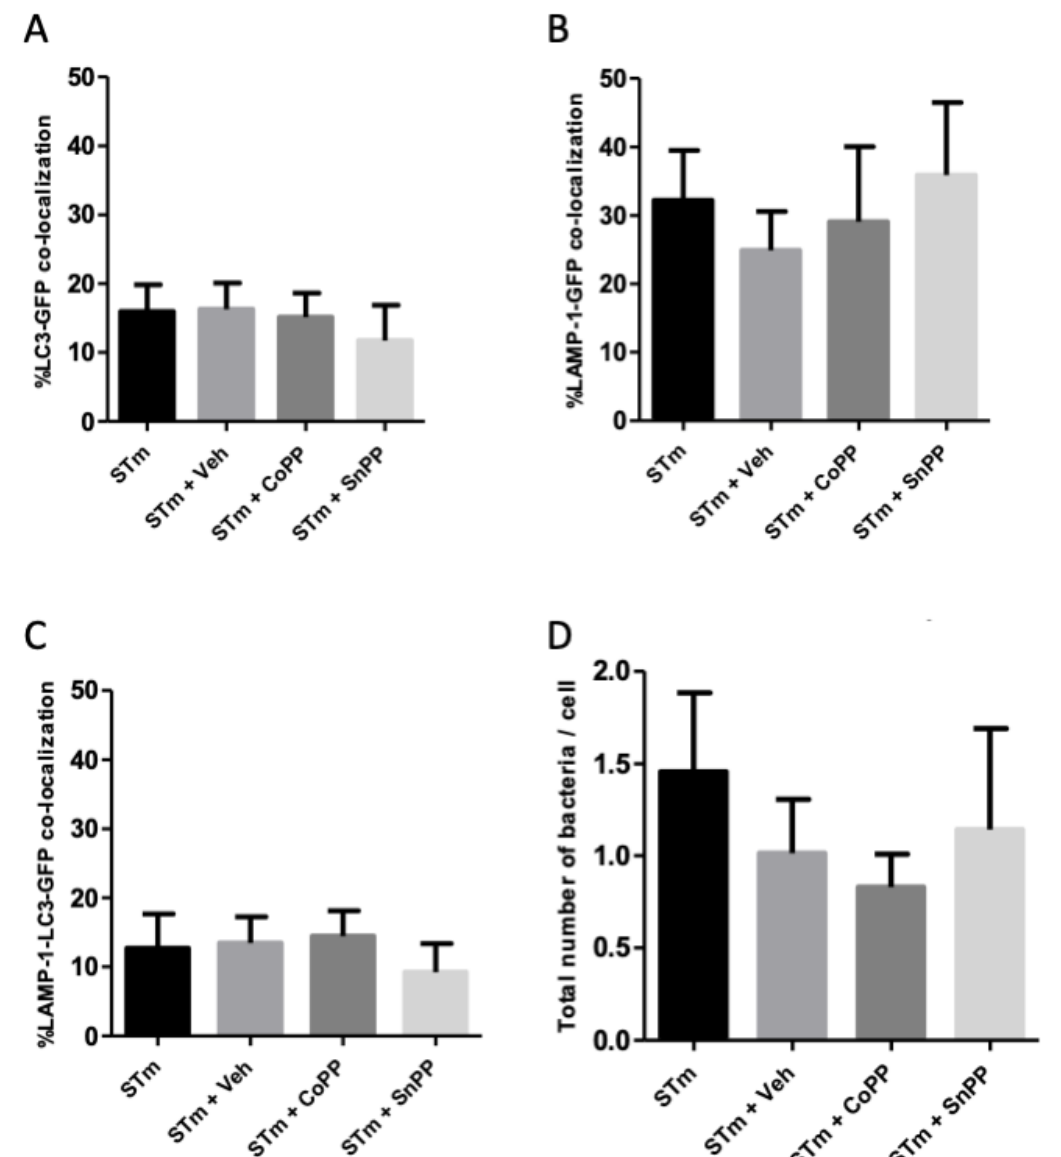
Figure 7. Quantification of colocalization of S . Typhimurium with autophagosome and lysosome markers in infected RAW264.7 cells. Microscopy images represented in Figure 6 were analyzed with ImageJ software. ( A ) Percentage of colocalization of S . Typhimurium-GFP with autophagosome (LC3). ( B ) Percentage of colocalization of S . Typhimurium-GFP with lysosomes (LAMP-1). ( C ) Percentage of colocalization of S . Typhimurium-GFP with autolysosomes (LC3 + LAMP-1). ( D ) Number of S . Typhimurium-GFP per cell. Representative of two independent experiments.